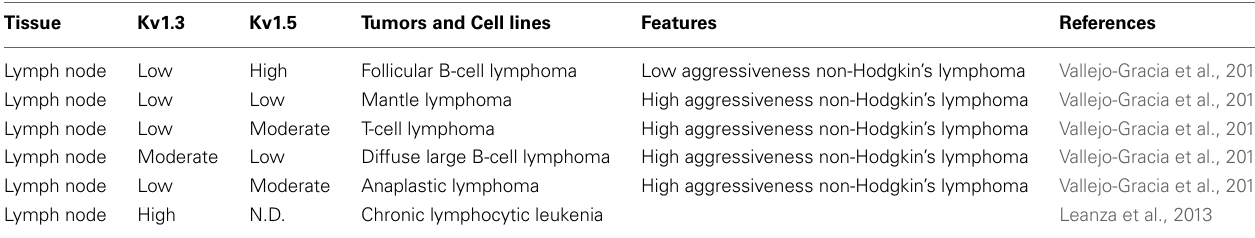
Table 2 | Expression of Kv1.3 and Kv1.5 in blood cancers.